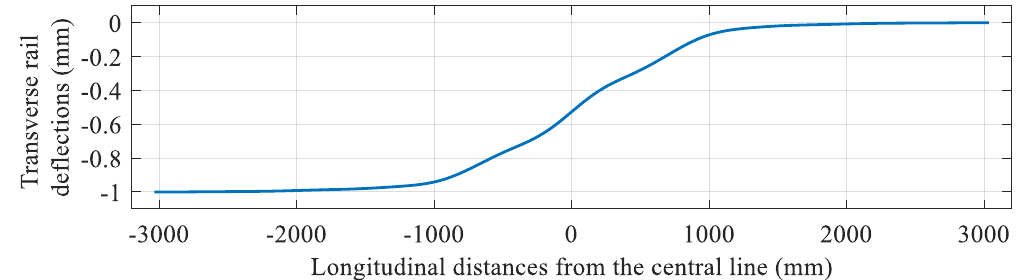
Figure 14. Transverse deflections of the rail under − 1 mm relative transverse displacement of the fixed side.